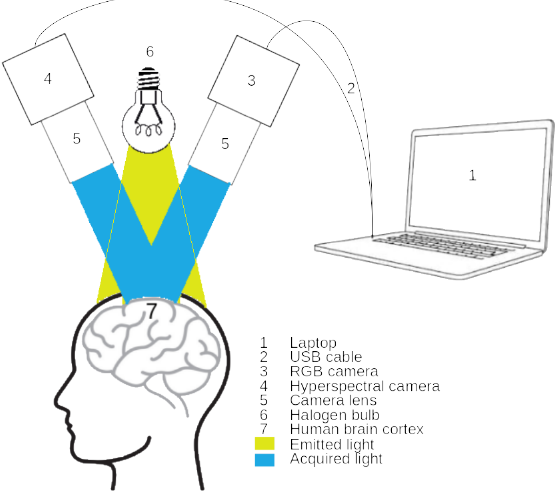
Figure 1. Schematic of the simulated imaging